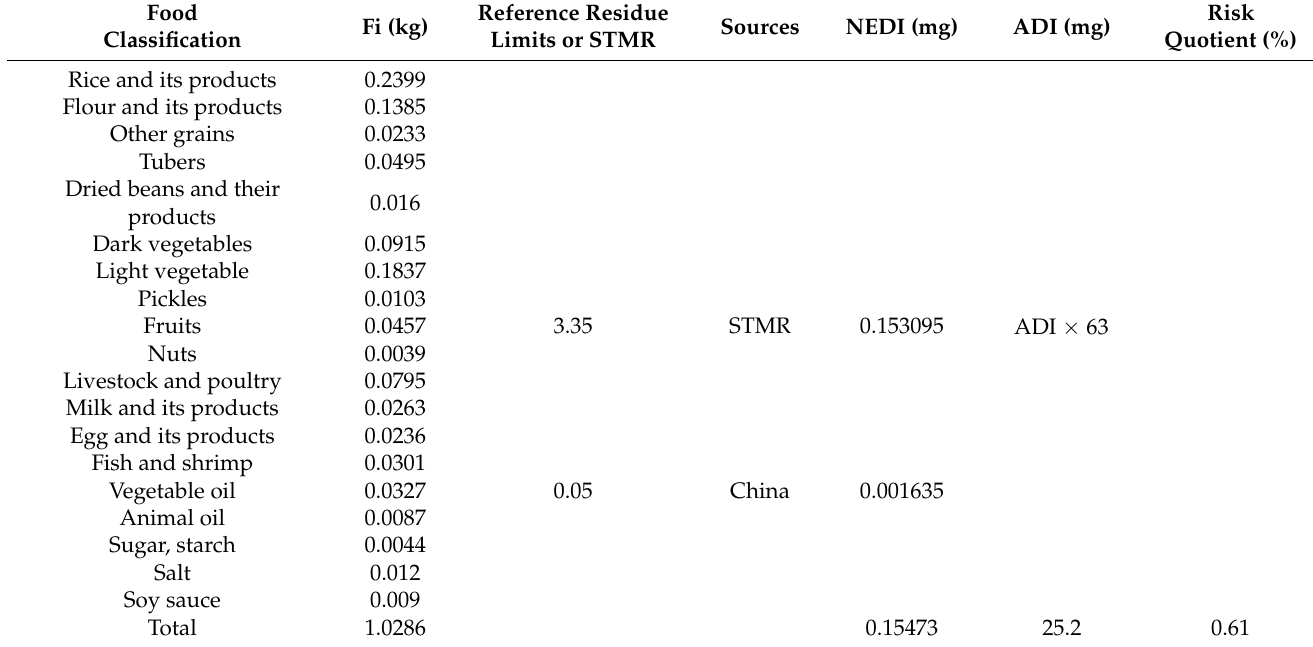
Table 6. The chronic dietary intake risk assessment of fludioxonil in accordance with Chinese dietary